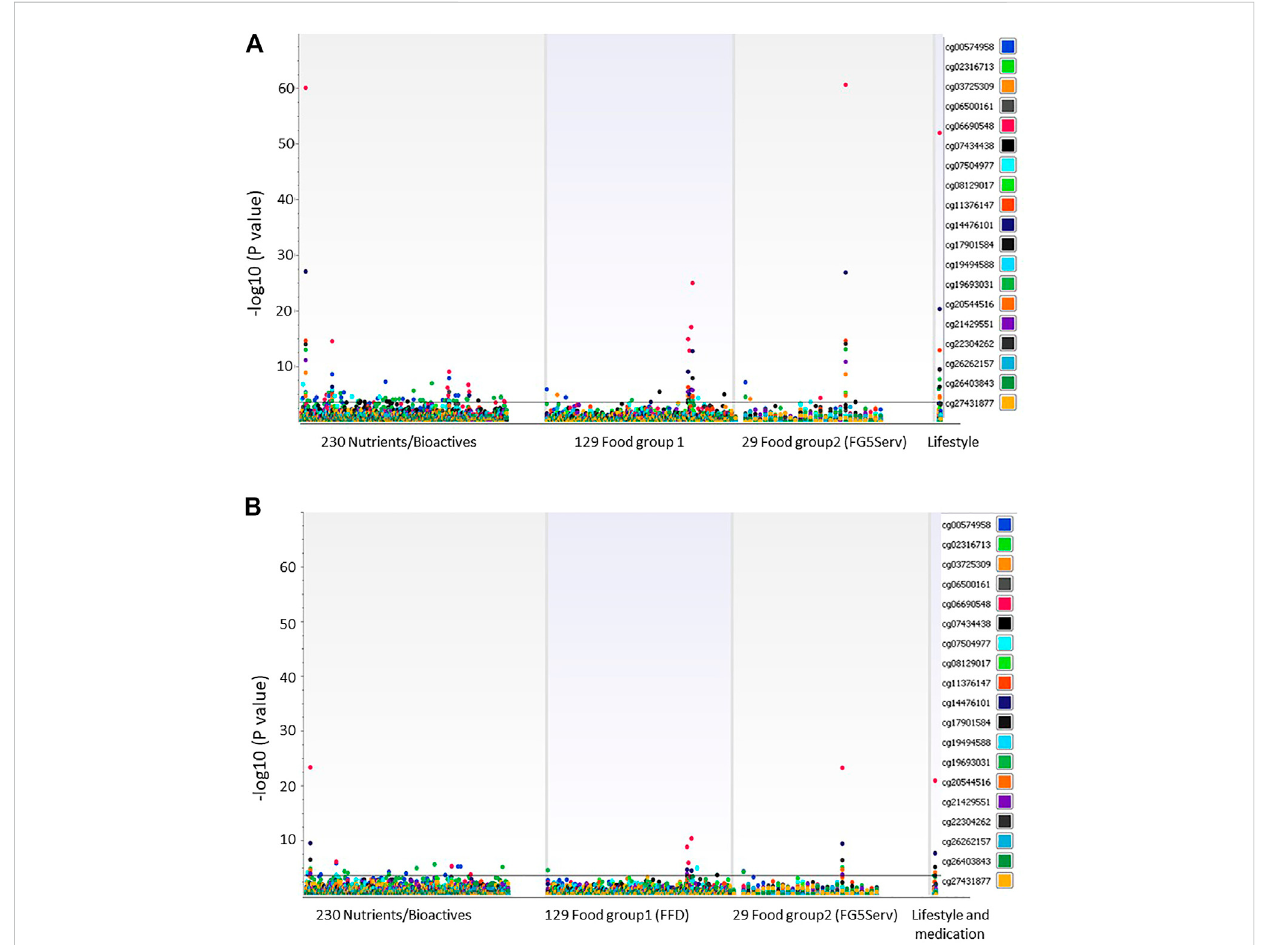
FIGURE 1 (A) Association between 19 DMSs and dietary intake and lifestyle factors at exam 8. All participants ( n = 1919) were examined while controlling the association tests for sex, age at exam 8, cell-type, family relationship, and medications for lipid lowering, hypertension, and diabetes. (B)